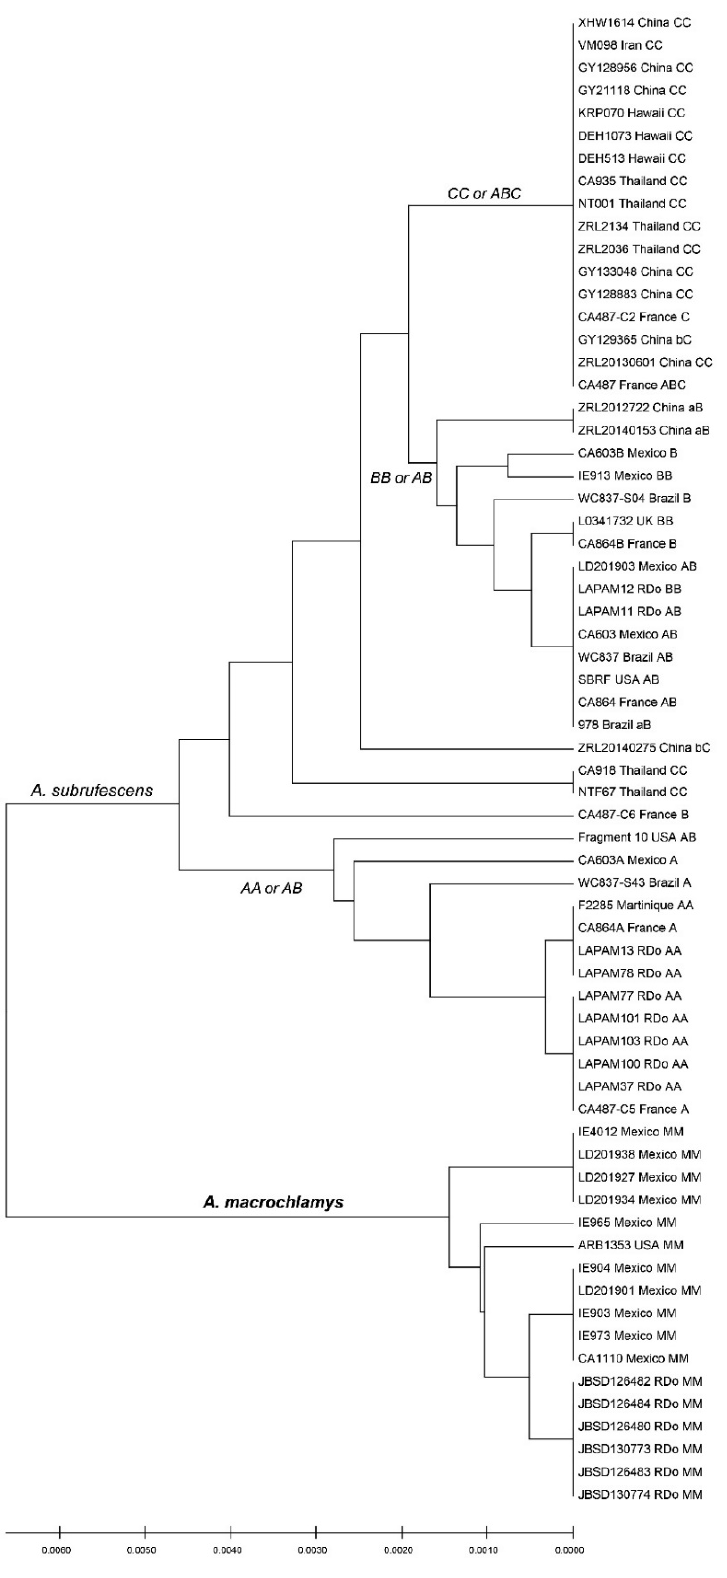
Figure 2. UPGMA analysis of 66 ITS sequences of A. subrufescens and A. macrochlamys . Lowercase letters in ITS type indicate that the characteristic polymorphisms of the type are not all present.